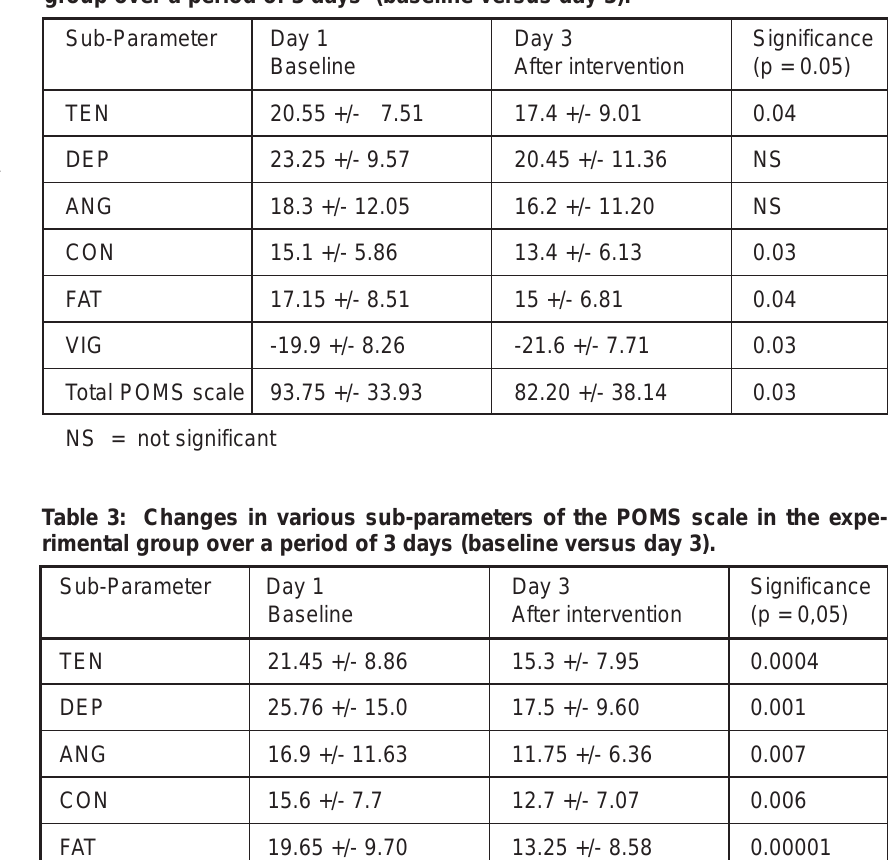
Table 2: Changes in various sub-parameters of the POMS scale in the control group over a period of 3 days (baseline versus day 3).